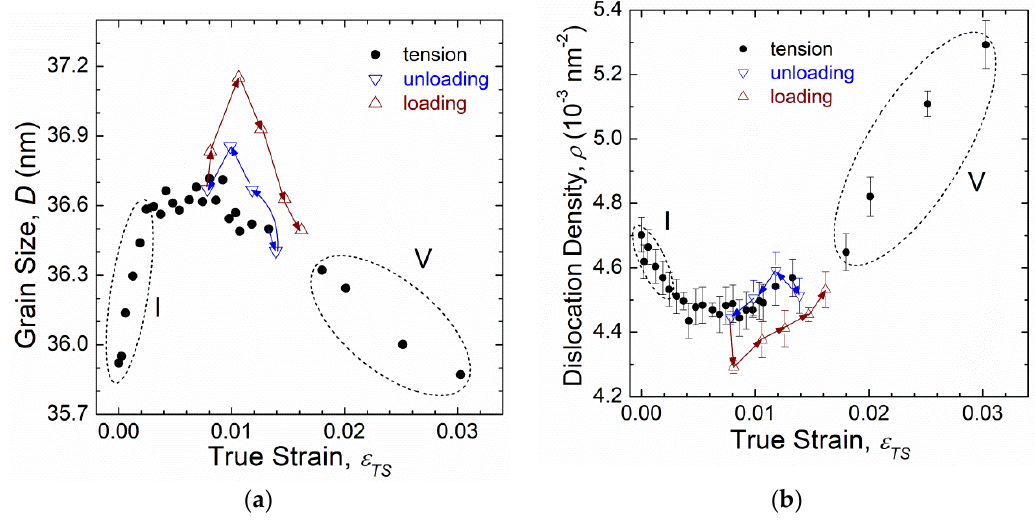
Figure 5. Grain size D ( a ) and dislocation density ρ ( b ) vs. macroscopic true strain ( ε TS ) for nc-Ag in tension and during unloading. Arrows: the sequences of unloading-loading in Regime IV. Dashed ovals: the elastic deformation stage (Regime I) and the final plastic deformation stage (Regime V).